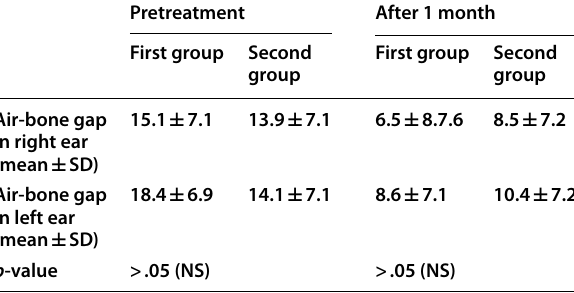
Student t test: NS no statistically significant difference